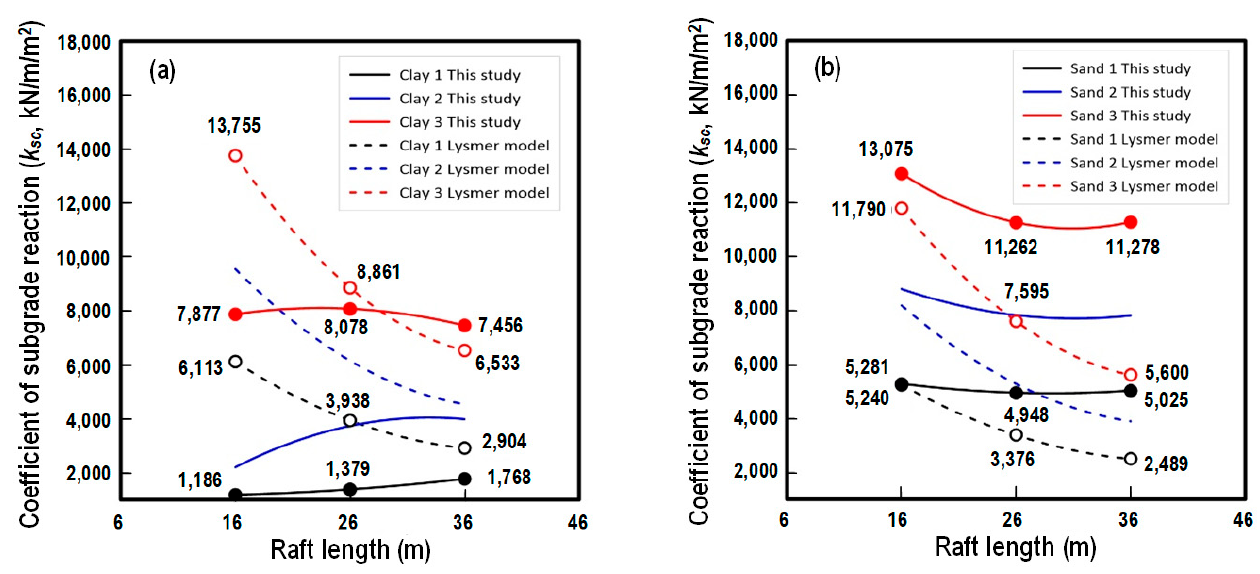
Figure 9. Comparisons of the coefficient of subgrade reaction k sc at the foundation center from this study and those from Lysmer’s model varying with foundation dimensions: ( a ) rafts in clays, ( b ) rafts in sands.